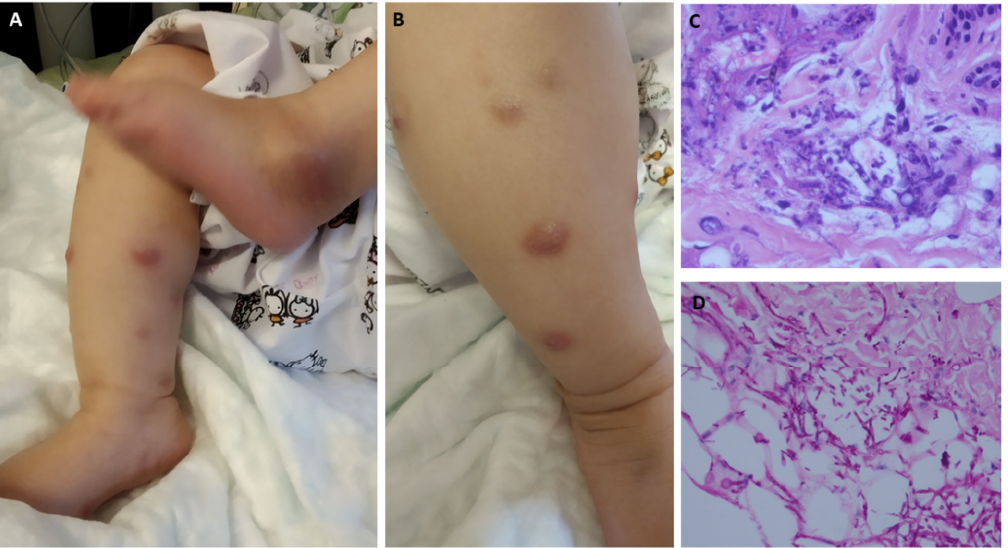
Figure 2. Typical clinical and histopathological features of invasive fusariosis. ( A , B ) Erythematous nodular skin lesions and septic arthritis of the left ankle in a 4-month-old girl with AML. ( C ) Biopsy of a cutaneous lesion demonstrating numerous fungal septate hyphae (hematoxylin and eosin, 400×). ( D ) Skin biopsy: periodic acid Schiff stain highlighting fungal elements (200×). Table 2. Microbiological data and antifungal susceptibility testing in 11 cases: minimal inhibitory concentrations (mcg/mL). Patient no.*